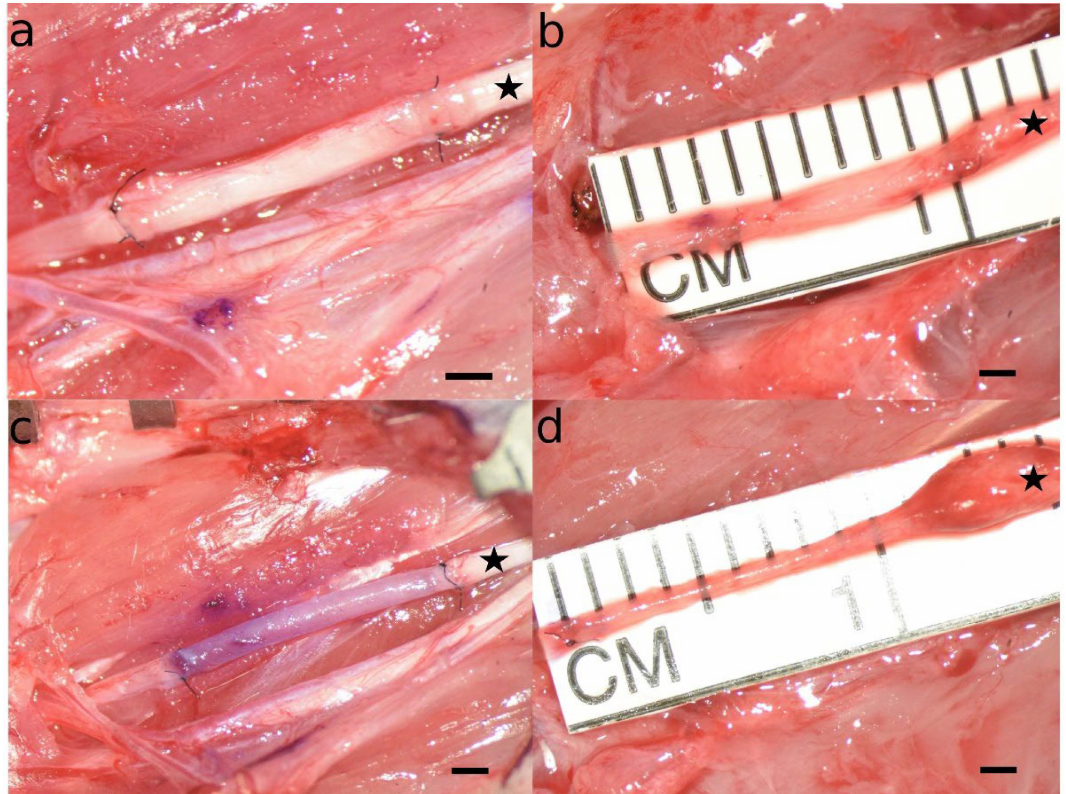
Figure 4. Microscopic appearance of autologous nerve grafts ( a , b ) and muscle-in-vein conduits ( c , d ) immediately after nerve reconstruction ( a , c ) and at the timepoint of sacrifice twelve weeks after the initial surgery ( b , d ). Note that while the autologous neve grafts at WPO12 were comparable both in length and diameter to the originals grafts sutured to the stumps of the median nerve during the initial surgery, the muscle-in-vein-conduits appeared markedly thinner and stretched at the